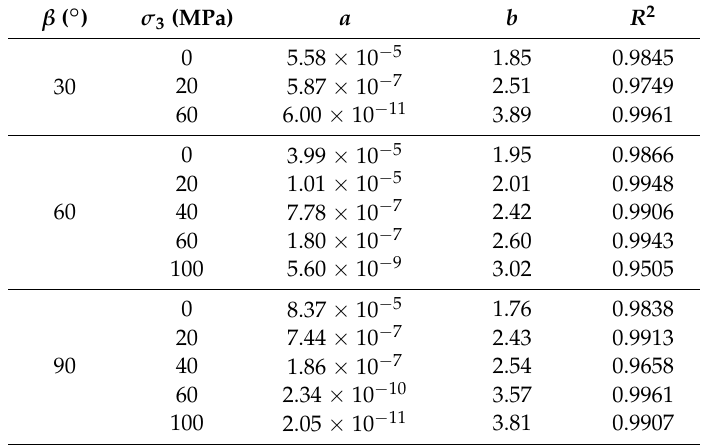
Table 3. Fitted constant parameters a and b in the damage evolution